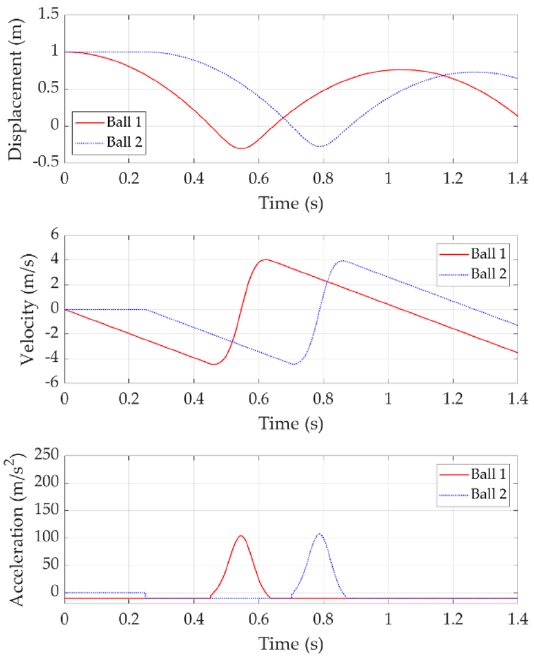
Figure 9. Double bounce with 0.25s release time